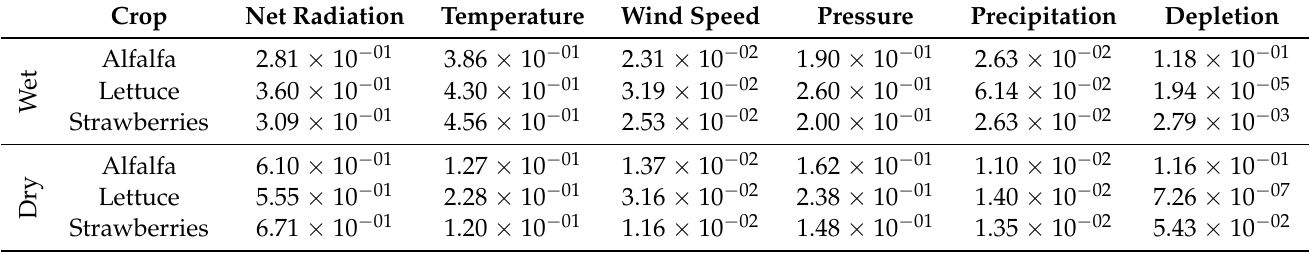
Table 4. Total effects for each crop in both wet and dry years. MaxIPerDay = 0.0075.